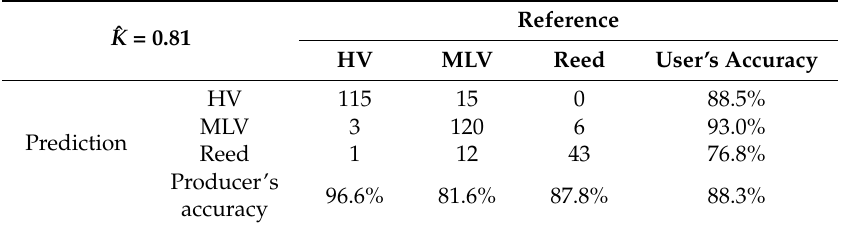
Table 5. Confusion matrix of the RF model using RapidEye and Landsat (1 July) (RF model 2). ˆ K = 0.81